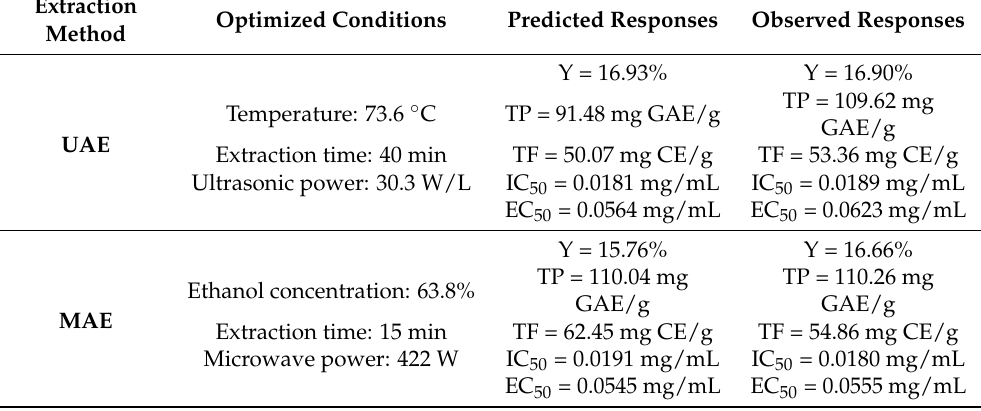
Table 5. Estimated optimal UAE and MAE